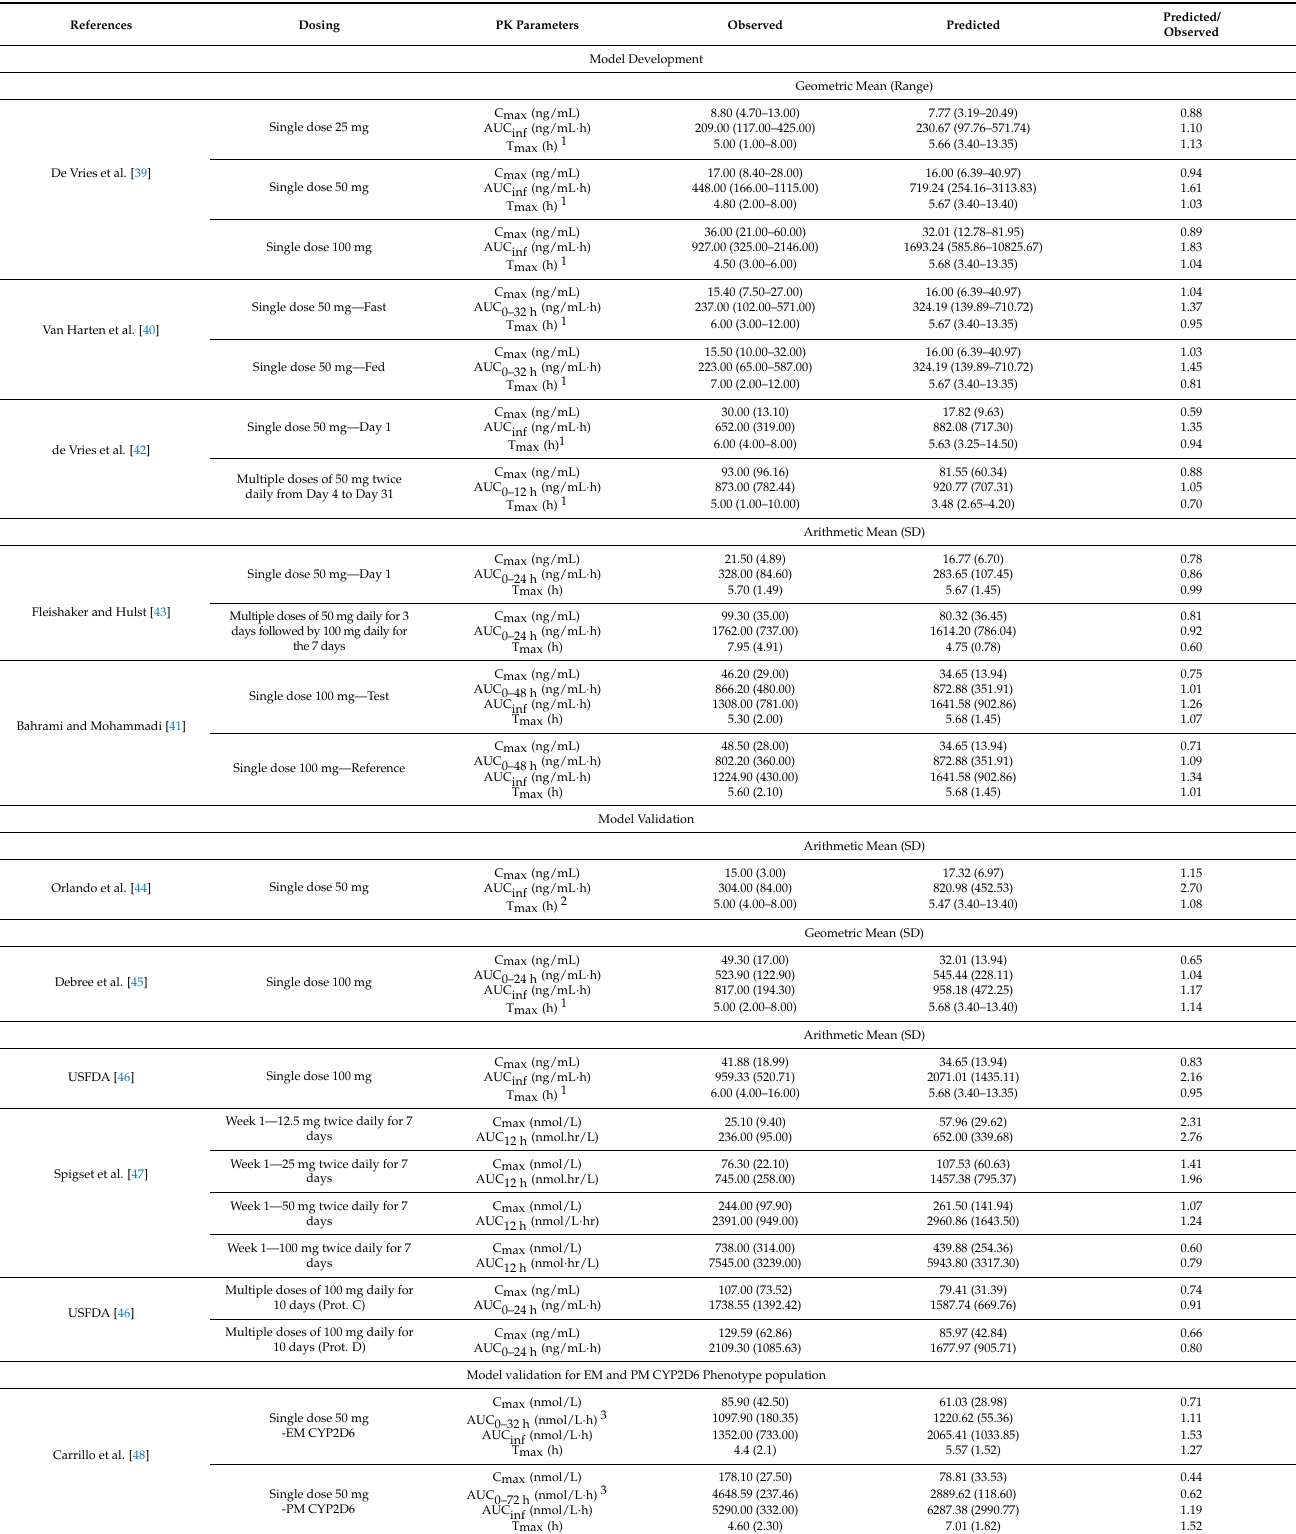
Table 3. Pharmacokinetics of single- and multiple-dose studies (predicted and